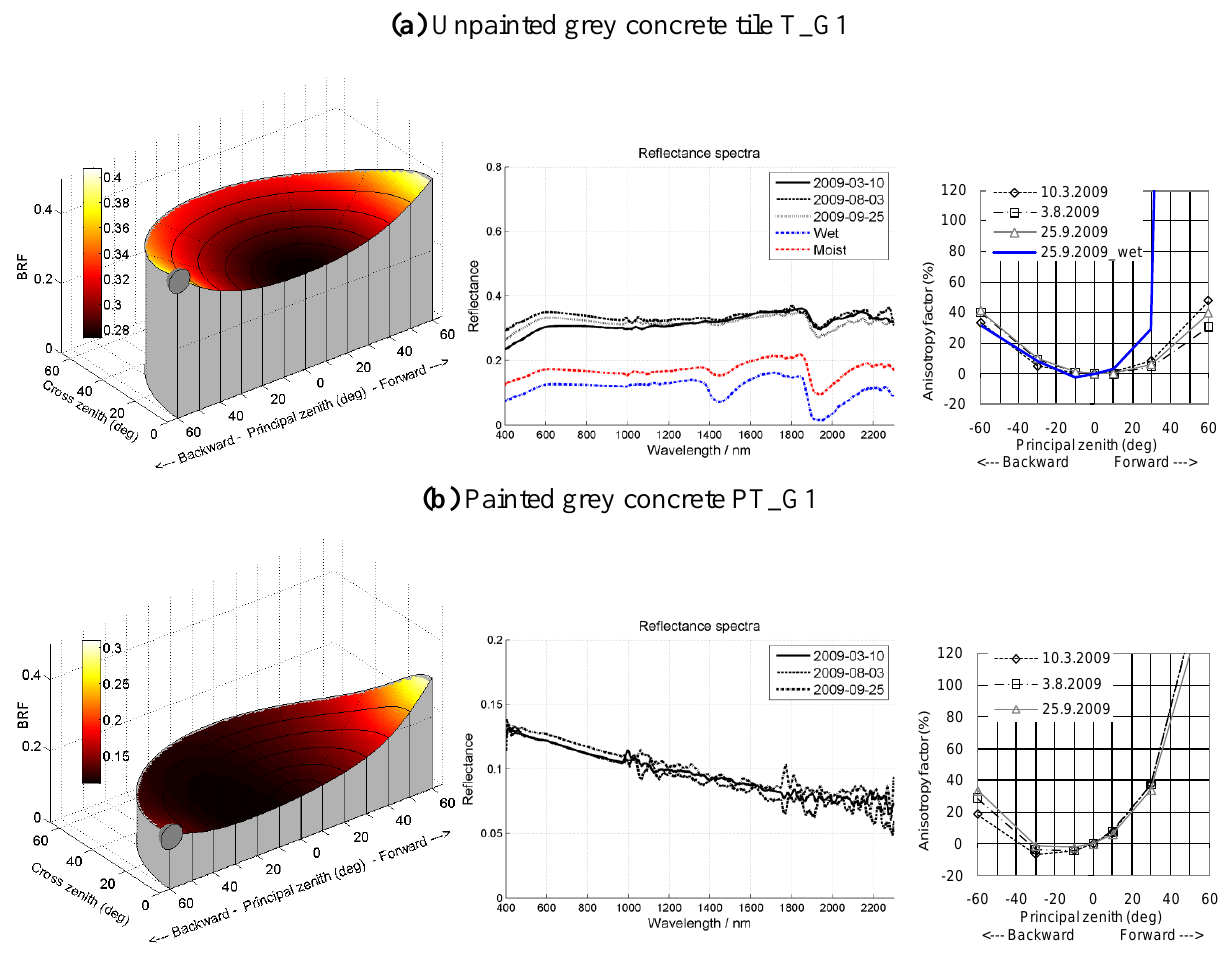
(b) Painted grey concrete